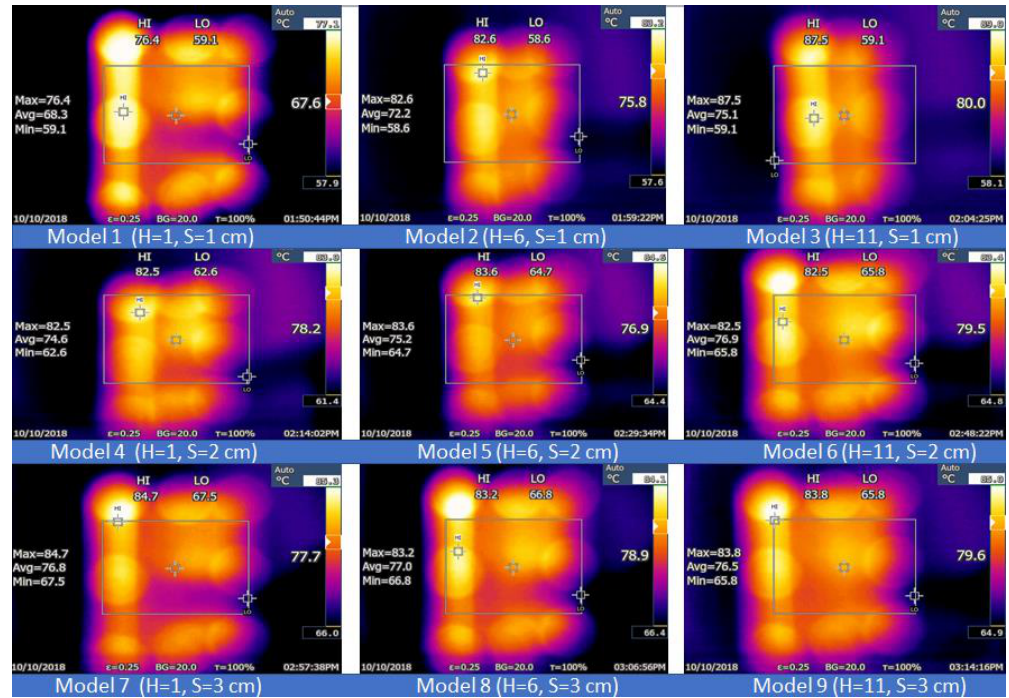
Figure 15. Thermographic distributions of the aluminum flat plate that present Models 1 to 9 at Re = 17,000.